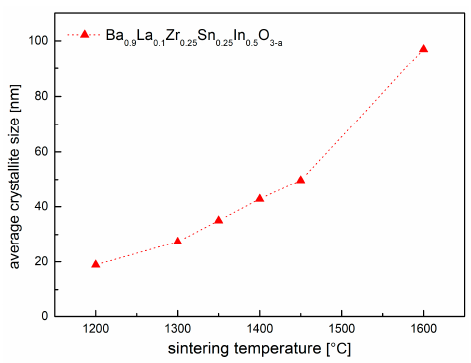
Figure 3. Calculated average crystallite size of Ba 0.9 La 0.1 Zr 0.25 Sn 0.25 In 0.5 O 3 − a as a function of the sintering temperature.